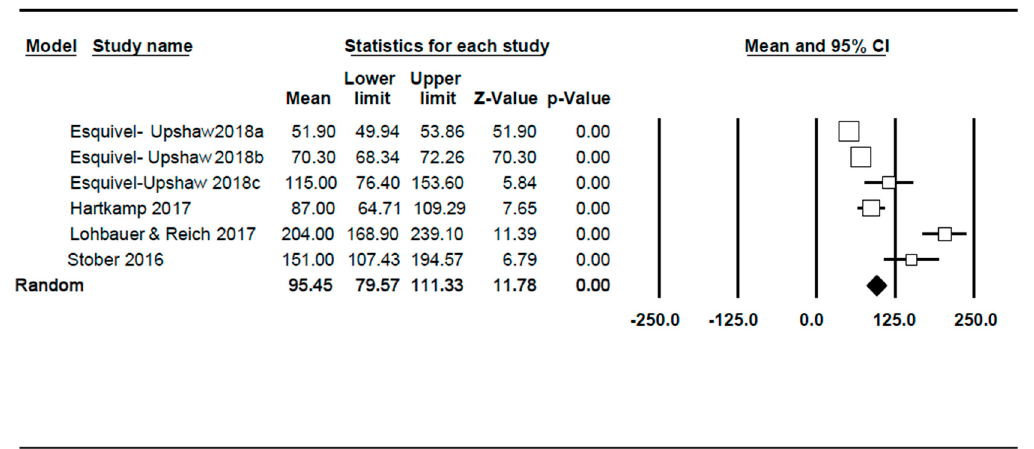
Figure 2. Forest-plot. The mean of maximum wear reported by each author over time and indicating the calculation of mean of global effect for the tooth antagonist to monolithic zirconia restorations.